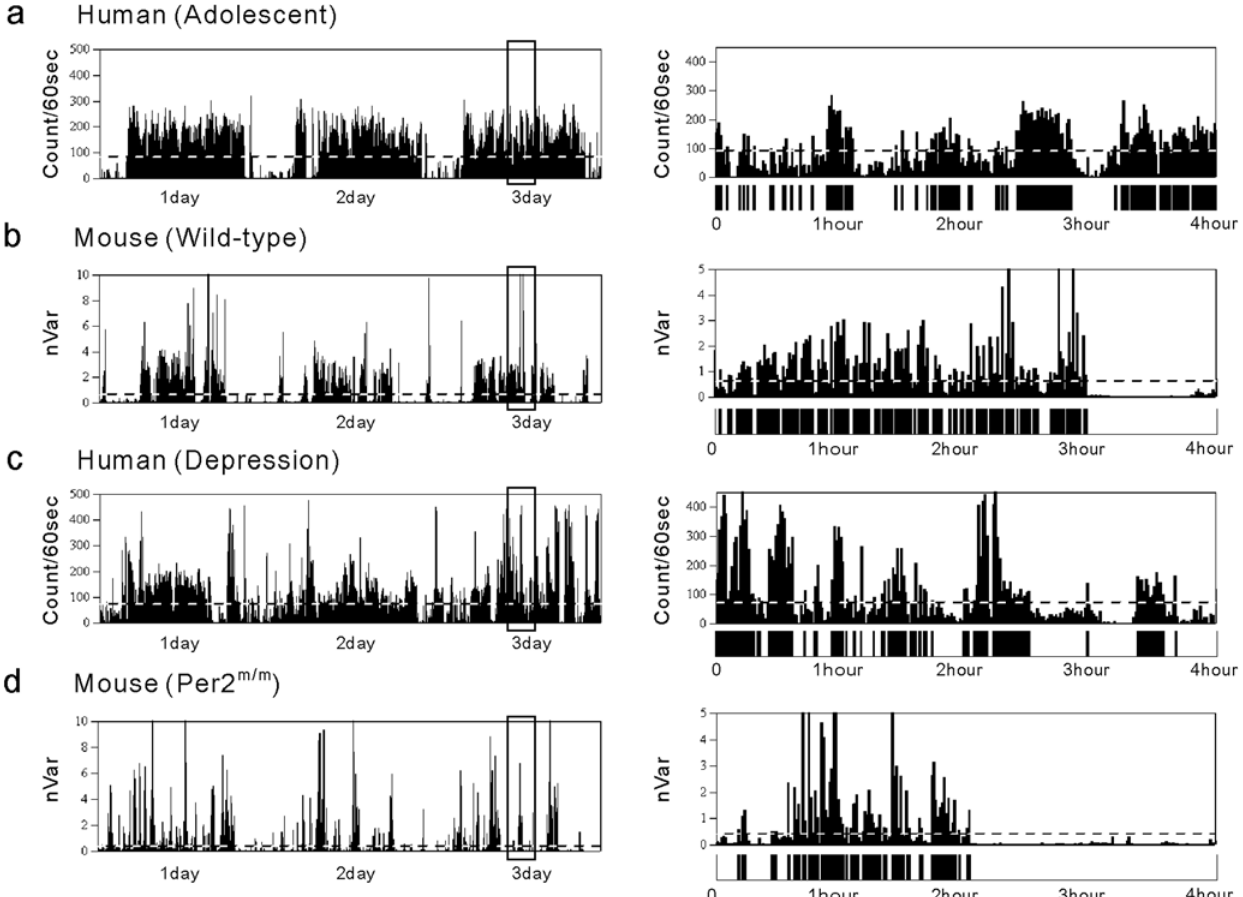
Figure 1. Fluctuation of locomotor activity in humans and mice. Illustrative examples of locomotor activity data for an adolescent ( a) , a wild- type (WT) mouse ( b ), a depression patient ( c ) [3], and a Period2 mutant ( Per 2 m / m ) mouse ( d ) over three consecutive days (left panels). The right panels are magnifications of the left panels with 4-hour periods during the 3rd subjective daytime. The overall average of non-zero activity counts is used for a threshold (horizontal dotted line), and the period in which the counts are successively below or above the threshold is coded respectively as a resting (open bar in bottom panels) or active (closed bar) period. Because the body weight varies across individuals, the mice’s activity counts in the vertical axis (nVar) are normalized by the mean variance of each